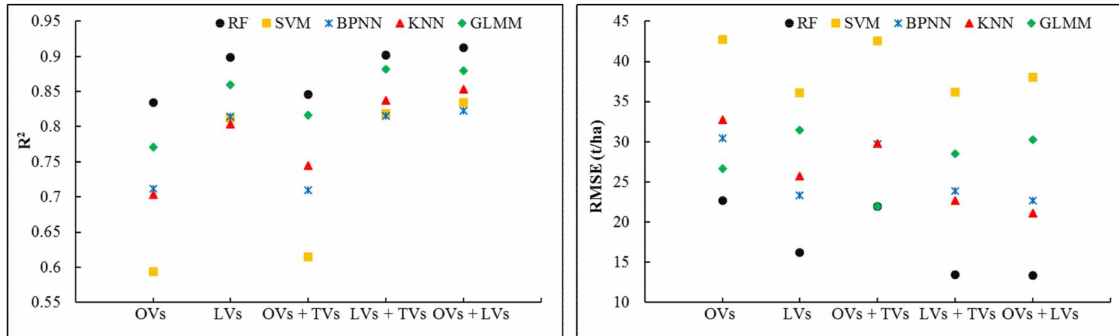
Figure 3. The mean R 2 and RMSE of AGB models, which used five methods based on different datasets. RF, Random Forest; SVM, Support Vector Machines; BPNN, Back Propagation Neural Networks; KNN, K-Nearest Neighbor; GLMM, Generalized Linear Mixed Model; OVs, optical variables; LVs, LiDAR variables; OVs + LVs, the combination of optical and LiDAR variables, OVs + TVs, the combination of optical and terrain variables; LVs + TVs, the combination of LiDAR and terrain